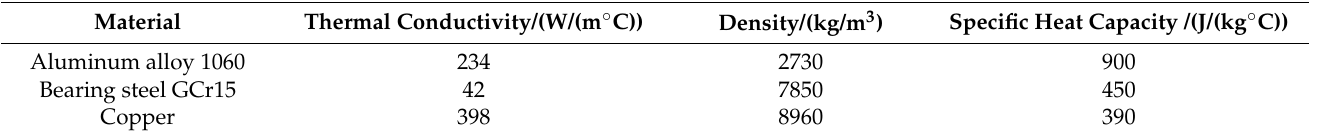
Table 4. Thermal conductivity, density and specific heat capacity of metal